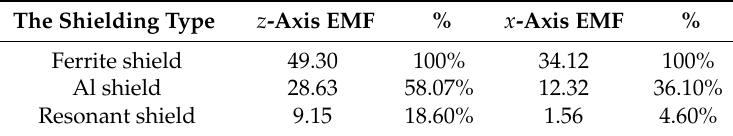
Table 7. Electromagnetic Field (EMF) averages for z -axis and x -axis observation points.